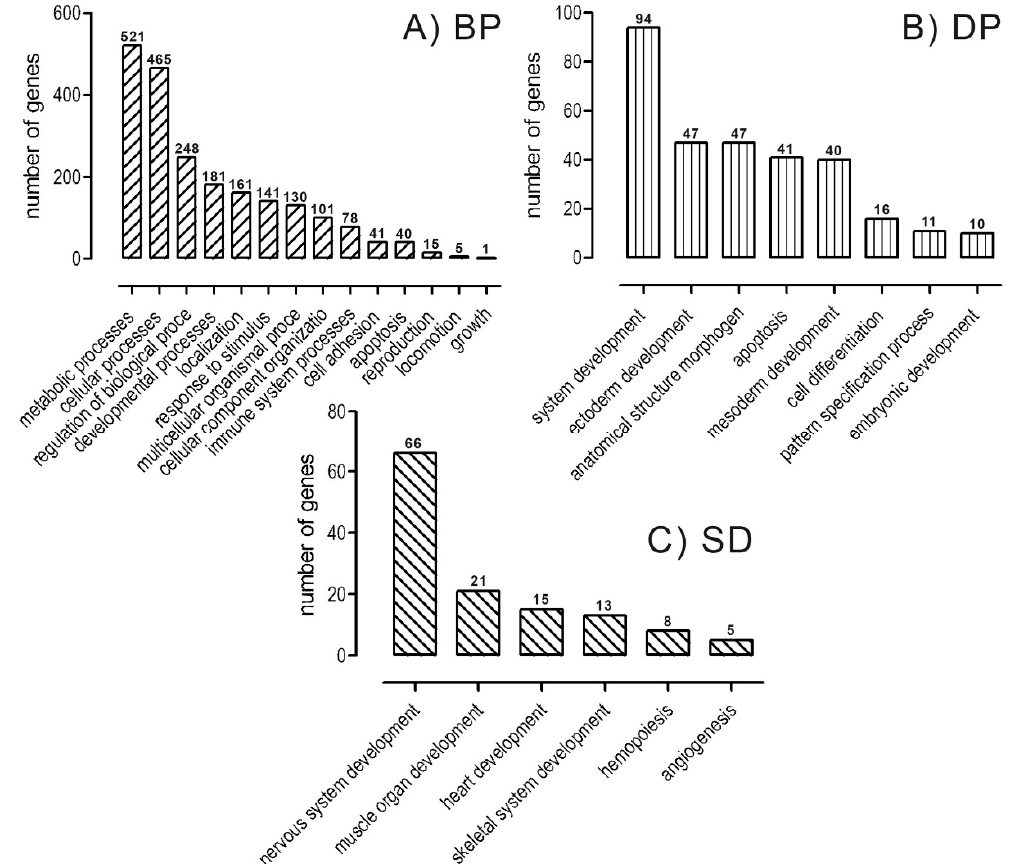
Figure 2. Functional classification of the identified genes that differed statistically significantly ( p ≤ 0.05) in expression between proliferating muscle cells of 15-month-old bulls from beef breeds (LIM and HER) and HF, a dairy breed, in terms of their involvement ( A ) in biological processes (BP), ( B ) developmental processes (DP) and ( C ) system development (SD). Analysis was performed using the Panther 7.0 software.